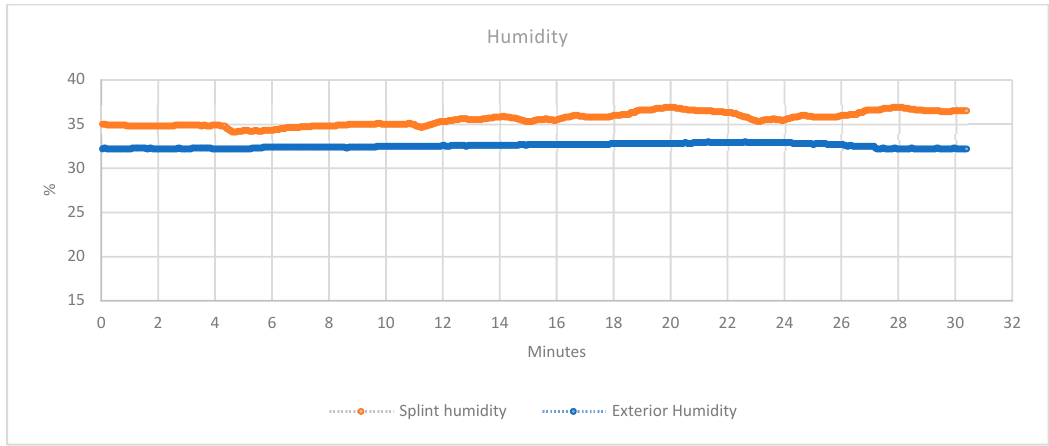
Figure 12. H Collected data of the humidity sensor.